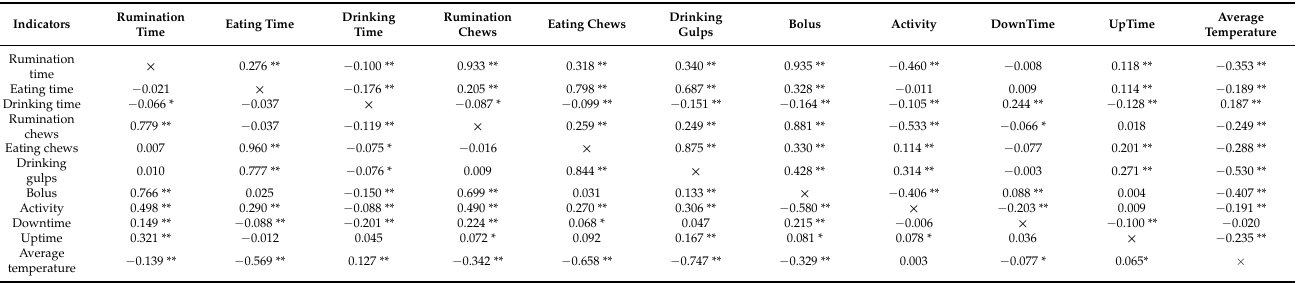
Table 3. Pearson’s correlation between biomarkers registered with real-time sensors using the RumiWatch noseband sensor by group.